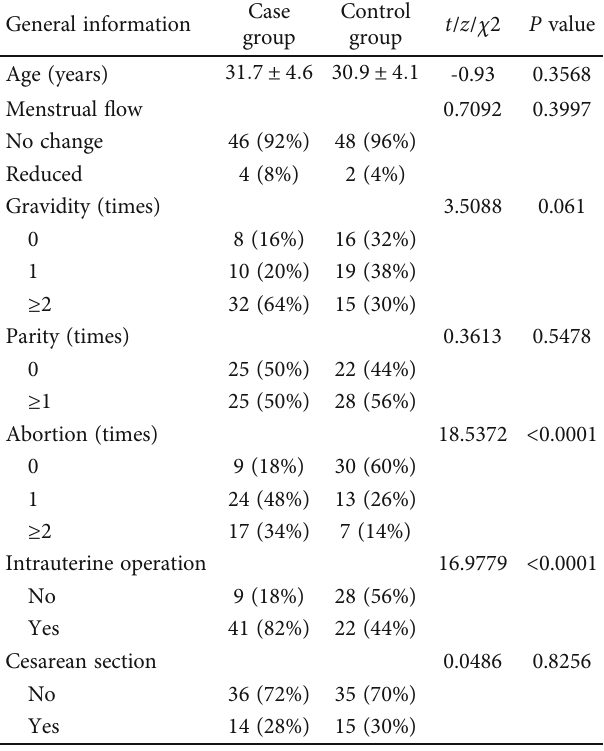
Table 1: Characteristics of the case group and the control